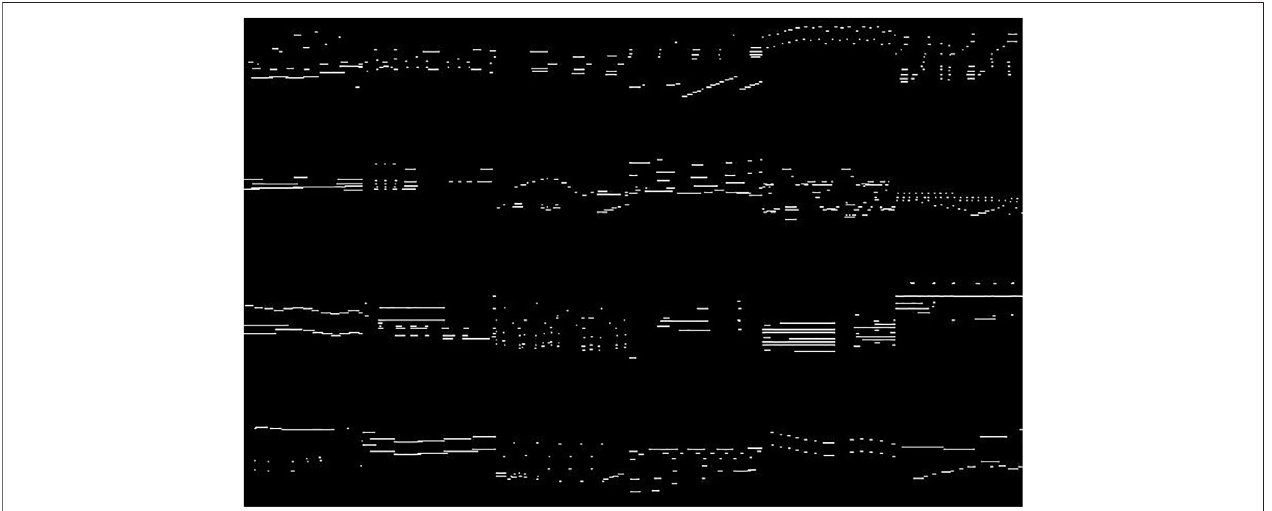
FIGURE8| 24examplesofrealpianorollsusedtotrainStyleGANPianorollsarrangedin4rowsand6columns.Theexamplesexhibitgreatvariationintheirmusical structure.